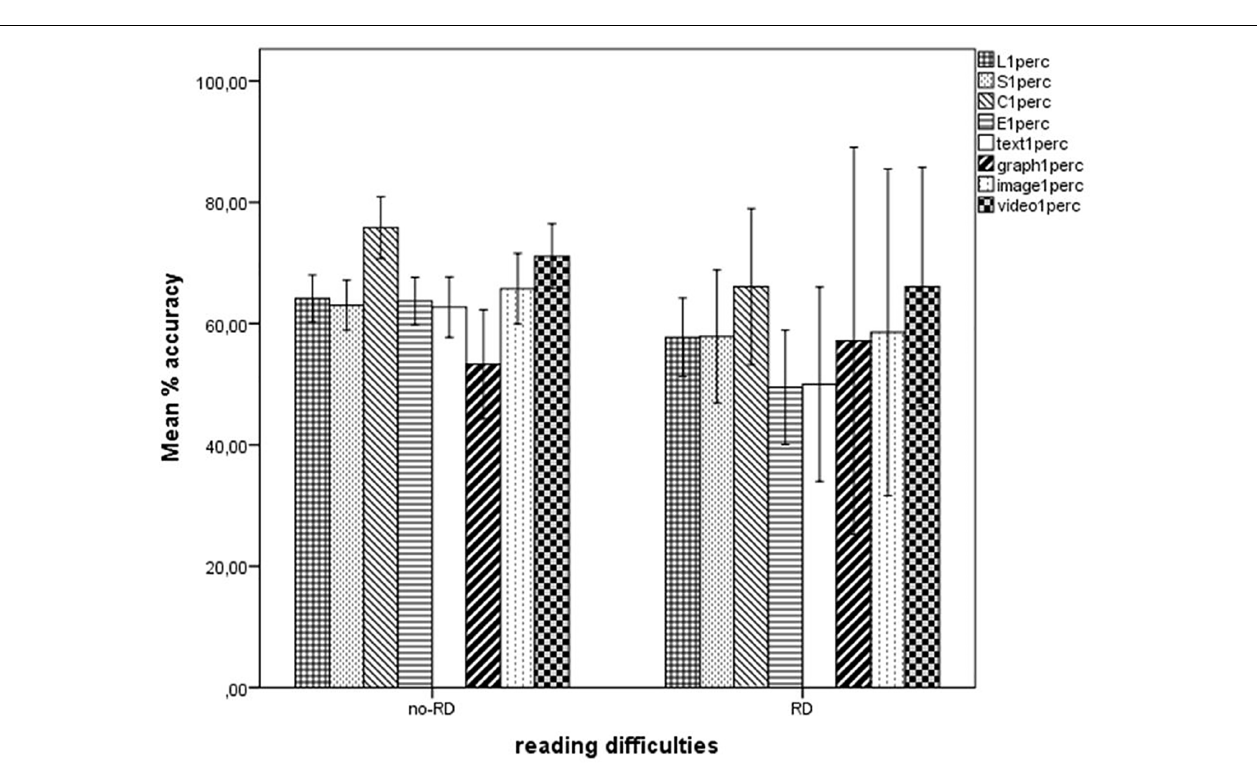
FIGURE 5 | Results obtained by students with and without reading difficulties on the four subscales Locate, Evaluate, Synthesize, and Communicate and on the four types of materials Text, Graph, Image, and Video, expressed as percent scores. RD, reading difficulties. Error bars illustrate 95% Confidence Intervals for the Mean.